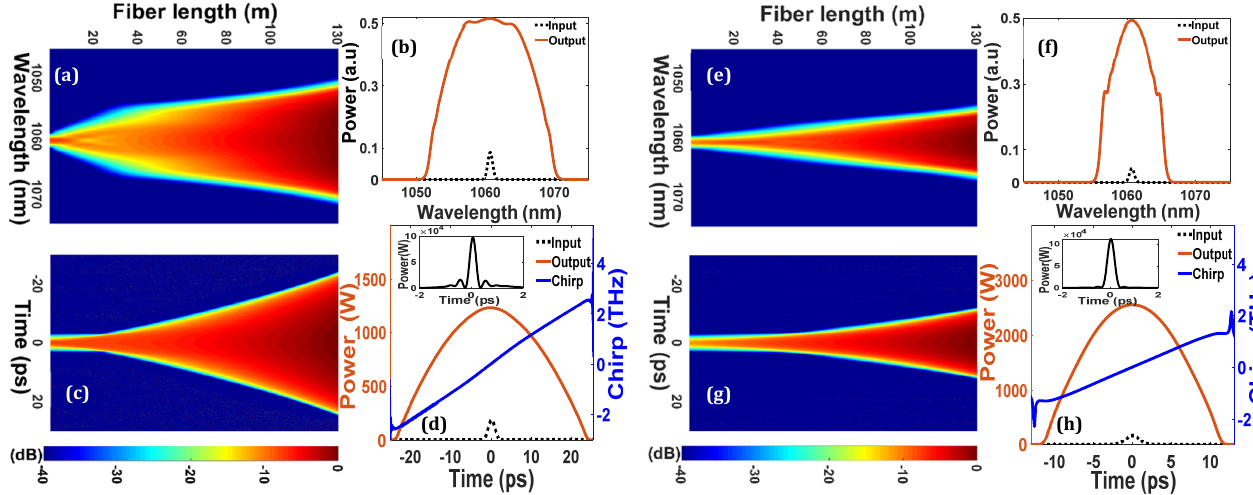
Figure 4. ( a – d ) The spectral and the temporal similariton evolutions and output forms of the LP 01 mode in the GRIN-F, and ( e – h ) in the STEP-F. Inset: the compressed pulses.